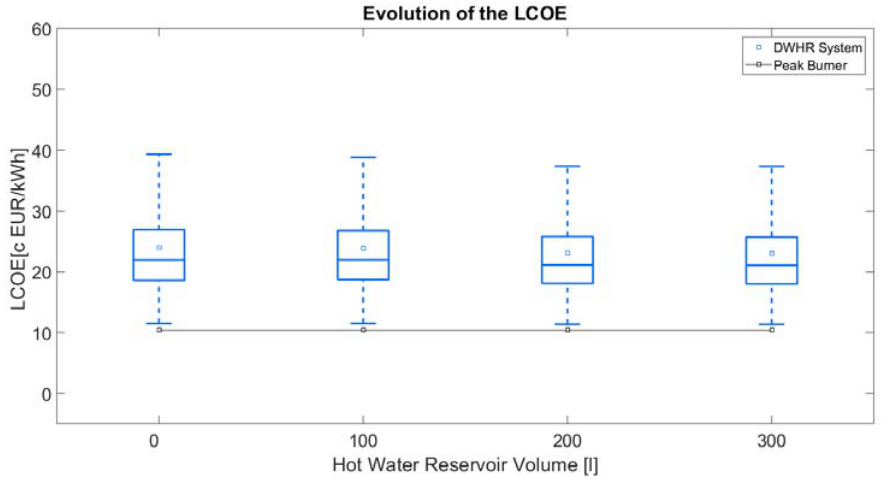
Figure 5. Evolution of the Levelized Cost of Energy with hot wat reservoir size.